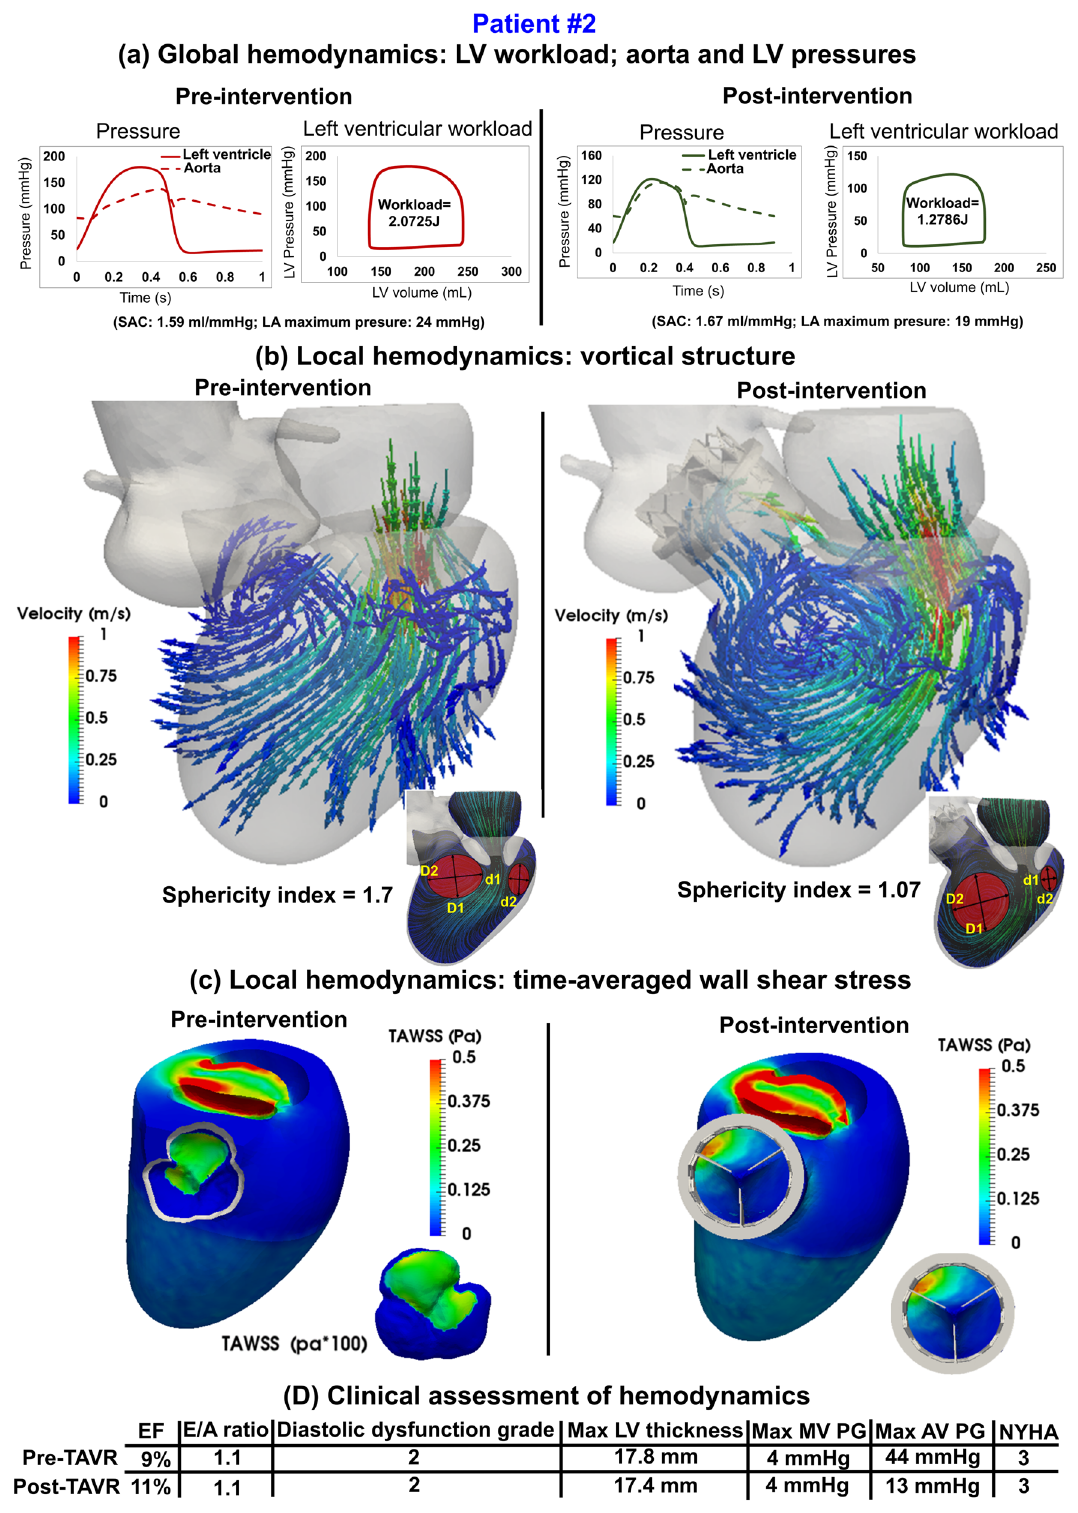
Figure 9. Changes in local and global hemodynamics in patient #2 between baseline and 90-day post-TAVR. ( a ) Global hemodynamics : LV workload, aorta and LV pressures; ( b ) Local hemodynamics : vortical structure; ( c ) Local hemodynamics : time-averaged wall shear stress; ( d ) Clinical assessment of hemodynamics. Local hemodynamics: cardiac fluid dynamics , e.g., details of the instantaneous 3-D flow and vortex formation. Global hemodynamics: (1) Metrics of circulatory function , e.g., detailed information of the dynamics of the circulatory system, and (2) Metrics of cardiac function , e.g., heart workload and the breakdown of workload contributions from each cardiovascular disease